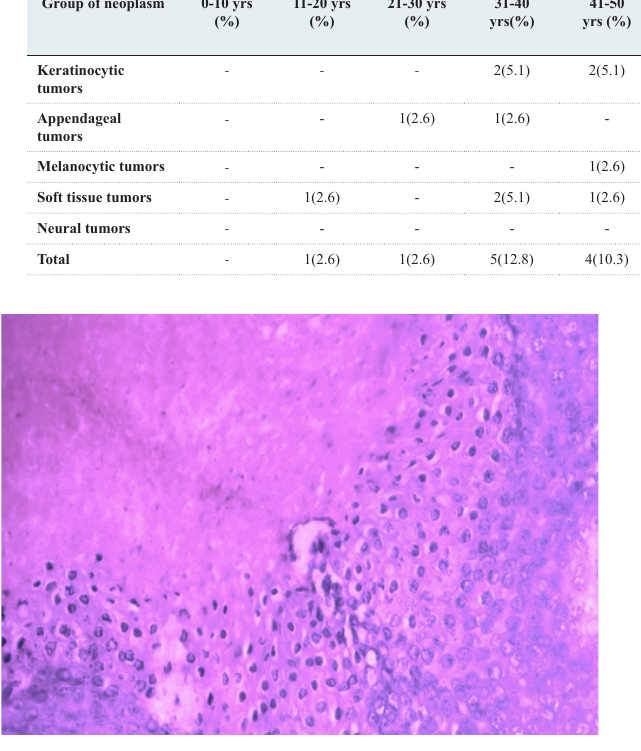
Figure 2: Sebaceoma. The tumor is composed of basaloid cells ad- mixed with clearer (sebaceous) cells with predominance of basaloid cells (HE stain;